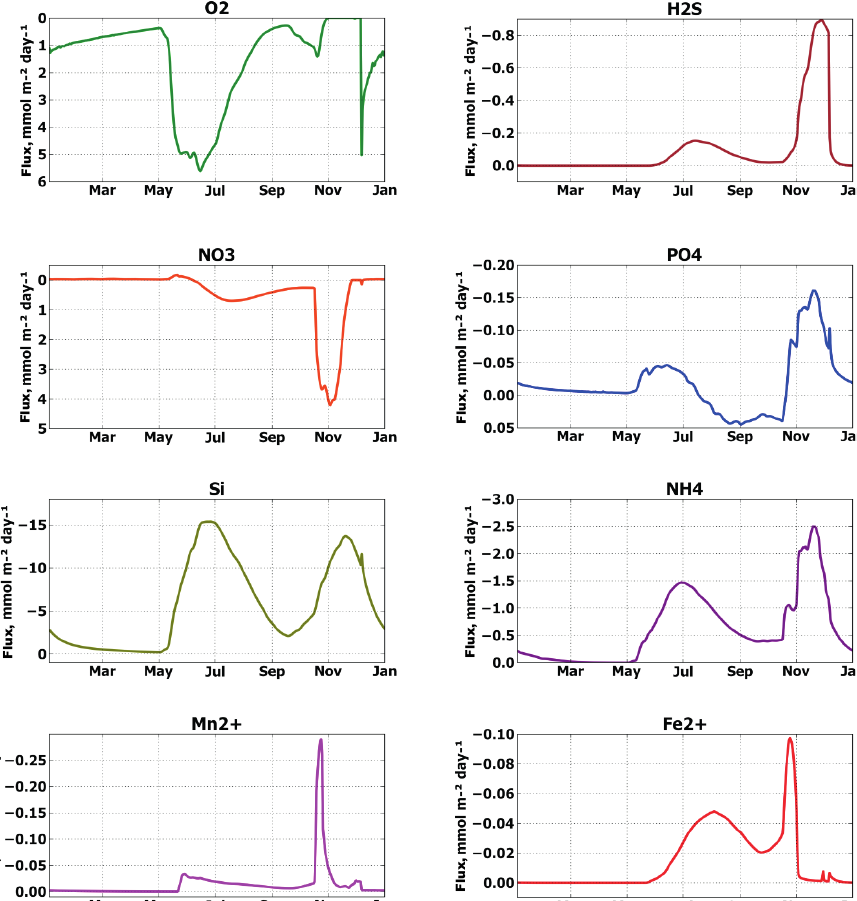
Figure 6. Simulated seasonal variability of vertical diffusive fluxes from the benthic boundary layer to the sediments of oxygen, hydrogen sul- fide, nitrate, silicate, ammonia, Mn(II), and Fe(II). Positive fluxes are downward and negative fluxes are upward. Units are in mmolm − 2 d − 1